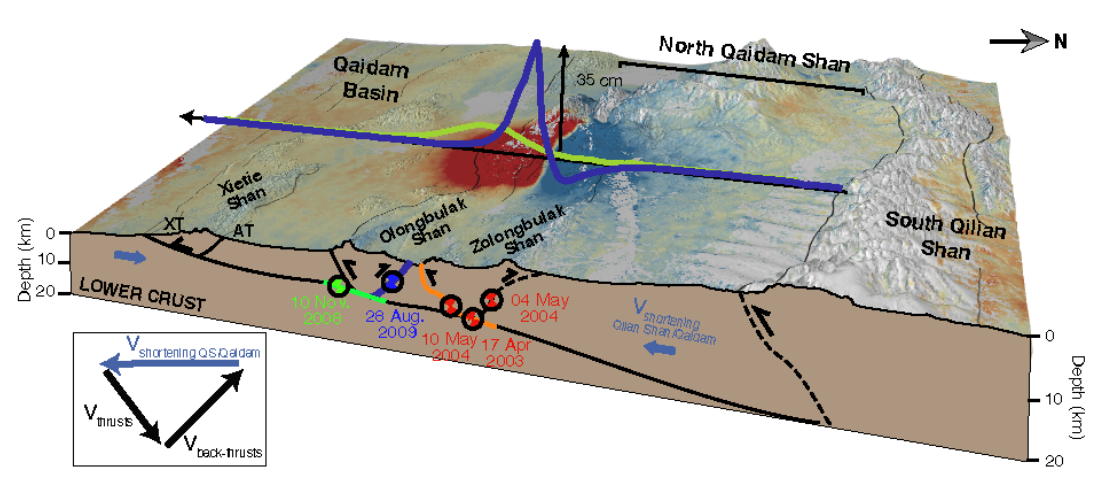
Figure 10. Three-dimensional block diagram of the proposed geometry for the North Qaidam thrust system superimposed on a digital elevation model (3 × vertically exaggerated), along with the cumulative LOS displacement map from descending track 319 and the 10 November 2008 and 28 August 2009 co-seismic LOS displacements profiles from Figure 2. Insert at the bottom left shows interpreted conservation of motion vectors across the fault-system, where high-angle thrusts and folds vertically partition the horizontal shortening transferred from the South Qilian Shan to the Qaidam